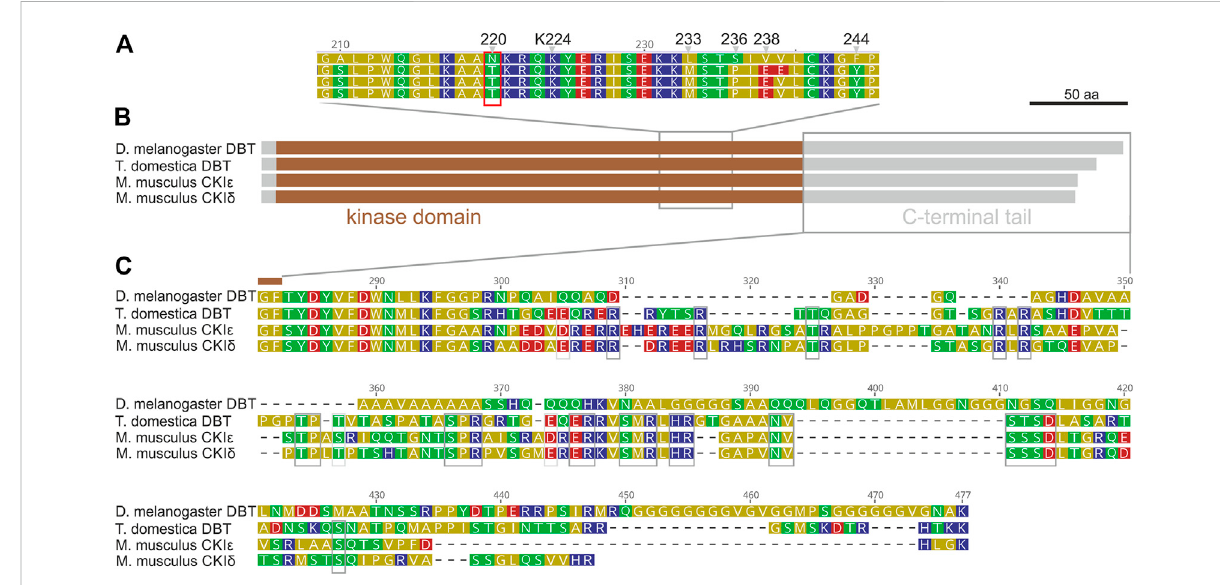
Drosophila melanogaster DBT differs from DBT of ancestral insect Thermobia domestica and both mouse ( M. musculus ) homologs, CKI ε and CKI δ . (A) A detail of the kinase domain with highlighted conserved Lysine K224 and Drosophila -speci fi c differences: N220, L233, S236, V238, and F244. (B) A schematic depiction of proteins with highlighted kinase domain, N- and C-terminal tails, and positions of detailed alignments shown in panels (A,C) . (C) Detail of the C-terminal tail, where grey boxes indicate residues conserved among CKI ε , CKI δ , and T. domestica